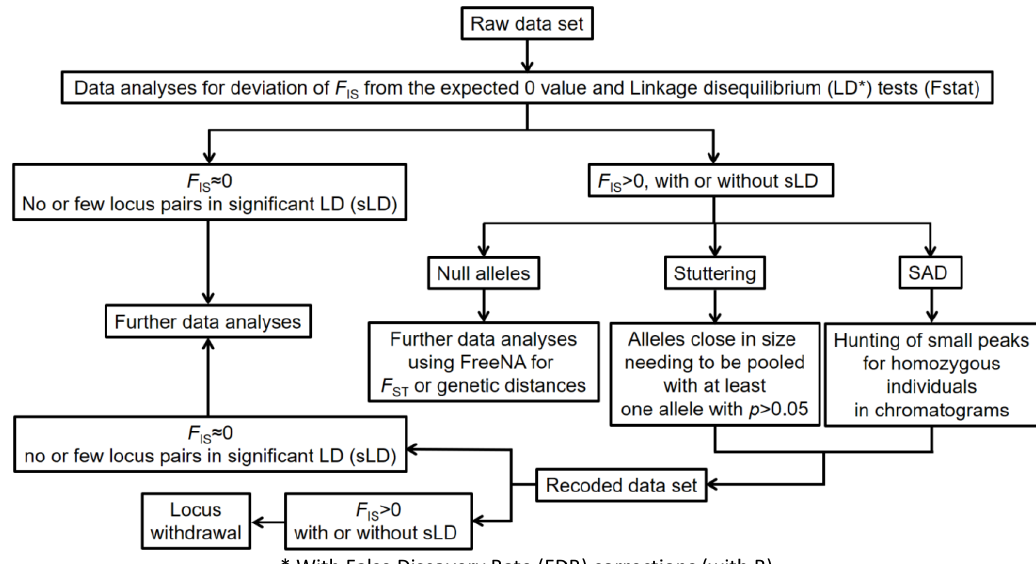
Figure 6. Flowchart of the recommended steps in population genetics data